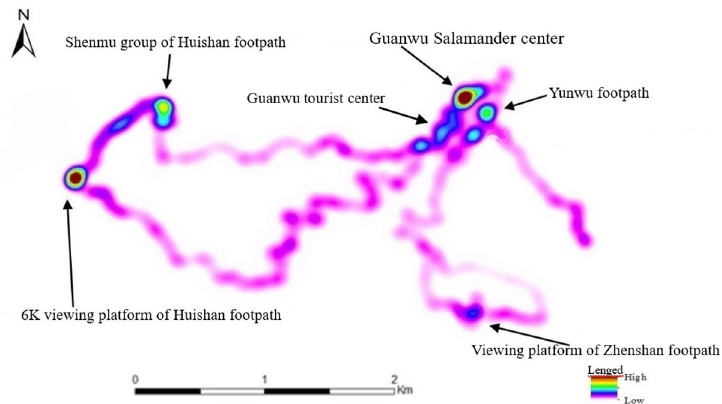
Fig 5. Map showing the distribution of tourists visiting attractions within the Guanwu National Forest Recreation Area in Taiwan.